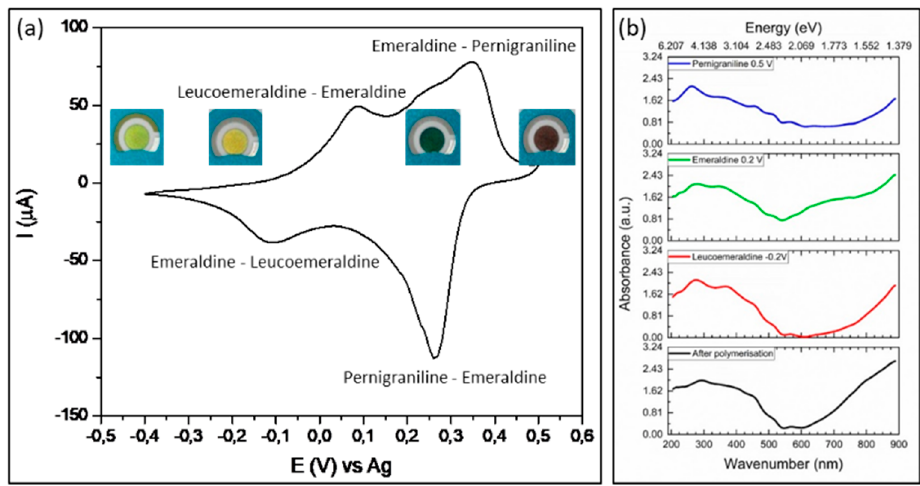
Figure 1. ( a ) Cyclic voltammetry (CV) with color changes (insets) of polyaniline (PANI) forms and ( b ) UV/VIS spectra of the PANI oxidation forms obtained at certain potentials ( − 0.2 V, 0.2 V, 0.5 V and − 0.3 V vs. Ag) in